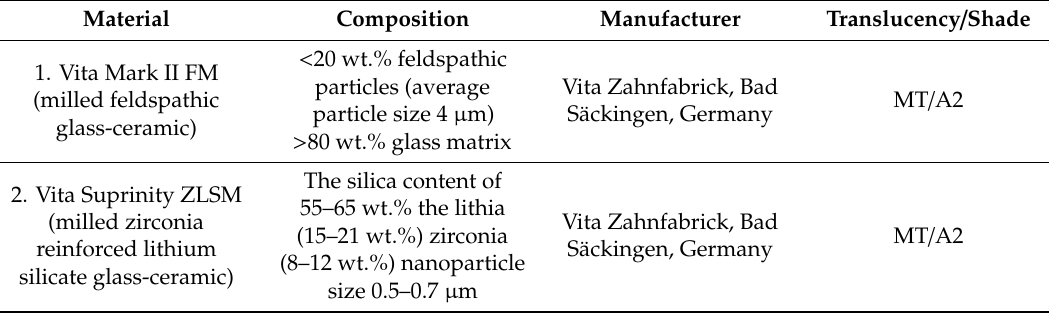
Table 1. CAD-CAM ceramic materials were selected for this study.